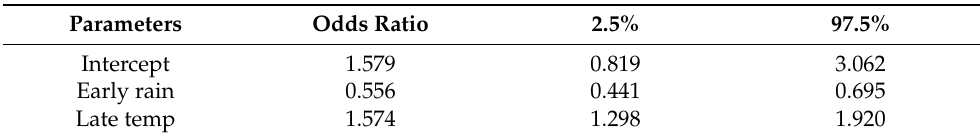
Table 3. Odds ratios and their 95% confidence intervals for parameters from the logistic regression model for the presence of aflatoxin.